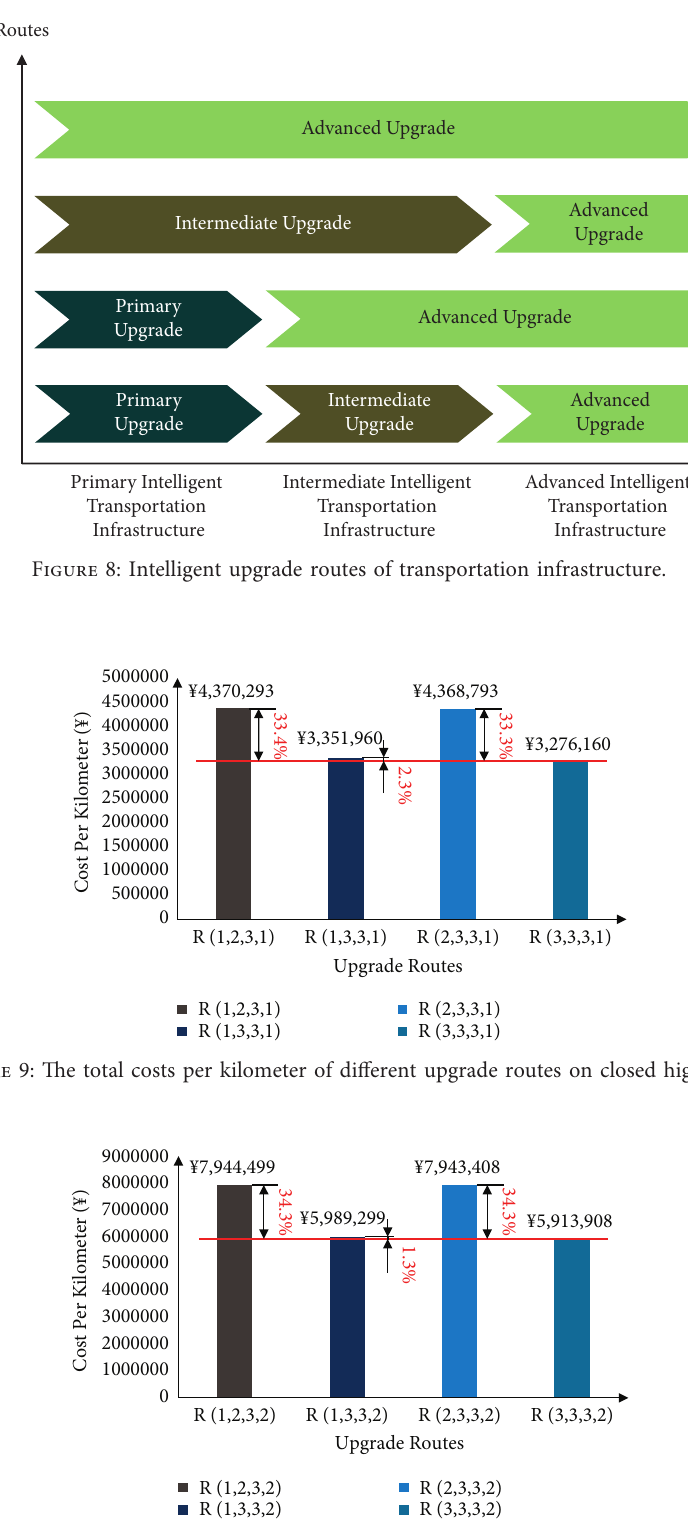
Figure 10: The total costs per kilometer of different upgrade routes on open urban